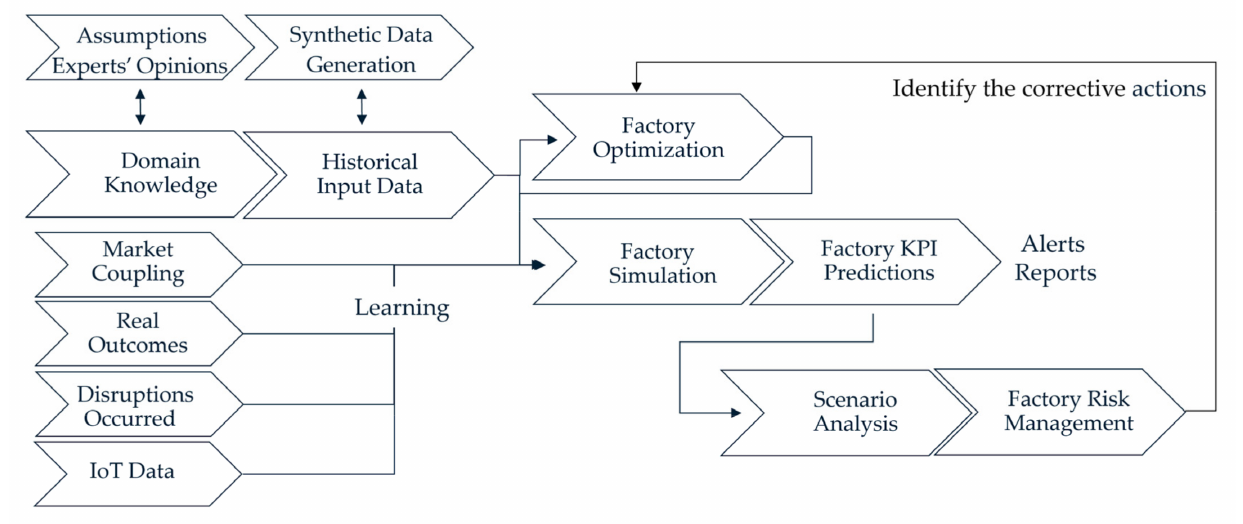
Figure 1. Illustration of an evolving, learning, and improving digital twin